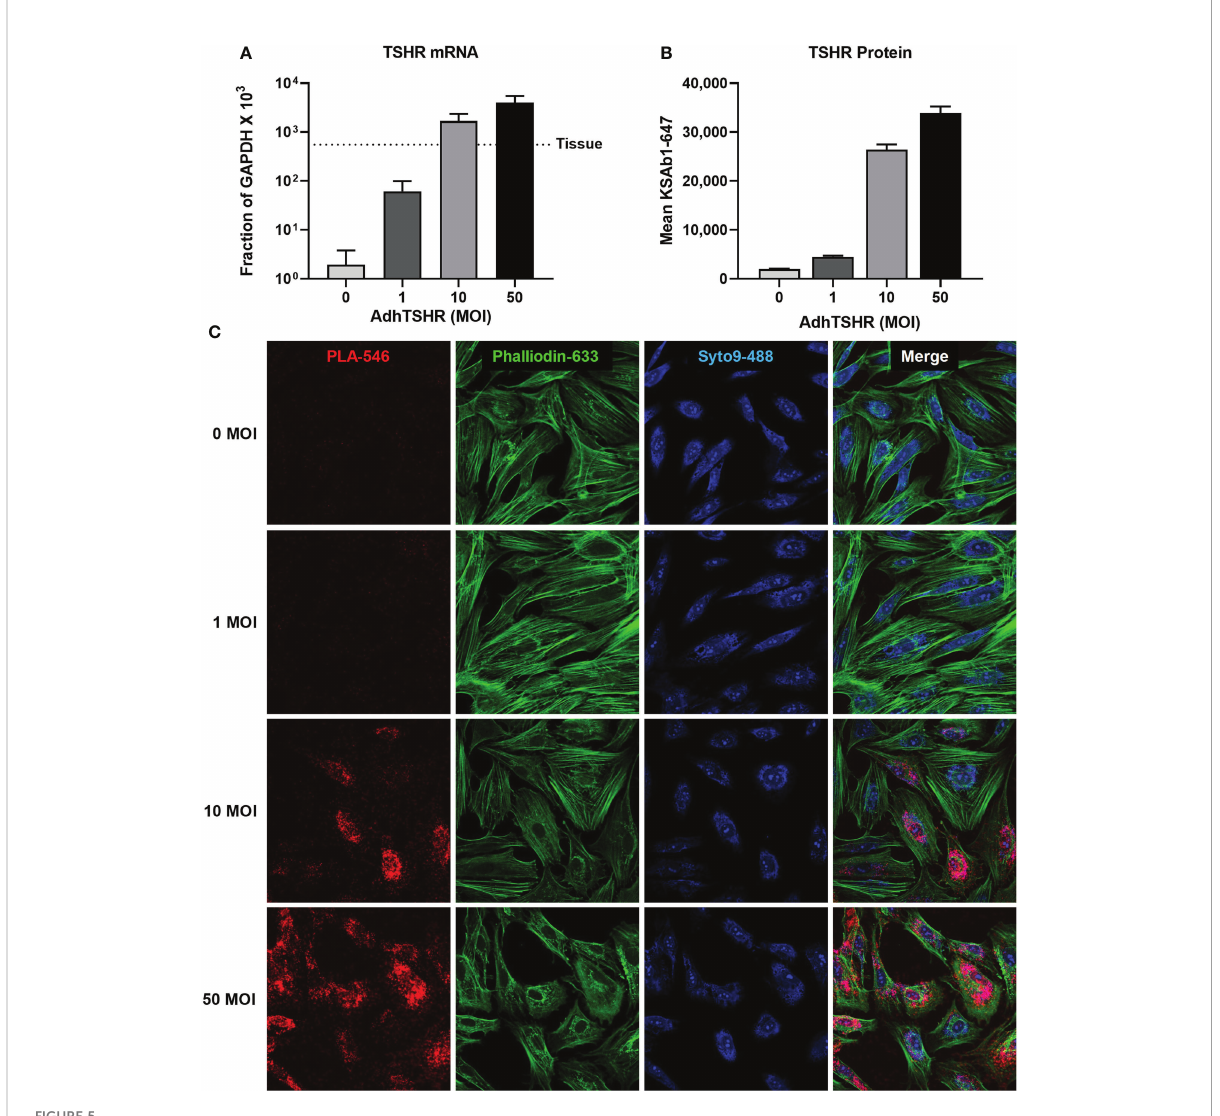
FIGURE 5 TSHR Homodimers in Human Thyrocytes. (A) Human thyrocytes were infected with adenovirus expressing full-length human TSHR (AdhTSHR) to approach mRNA expression levels measured in human thyroid tissue with increasing Multiplicity of Infection (MOI). (B) TSHR surface expression was measured on live thyrocytes using fl ow cytometry. Bars depict mean KSAb1-647 fl uorescence of labeled cells. (C) TSHR homodimers were detected on fi xed thyrocytes with PLA. Mouse anti-TSHR antibody KSAb1 was conjugated to PLUS and MINUS Duolink probes. Duolink signals are pseudo-colored in red. Phalloidin stain (green) determined cell area. Nuclei were stained with Syto9 (blue) and used to determine cell number. Figure reproduced with permission from Boutin et al.